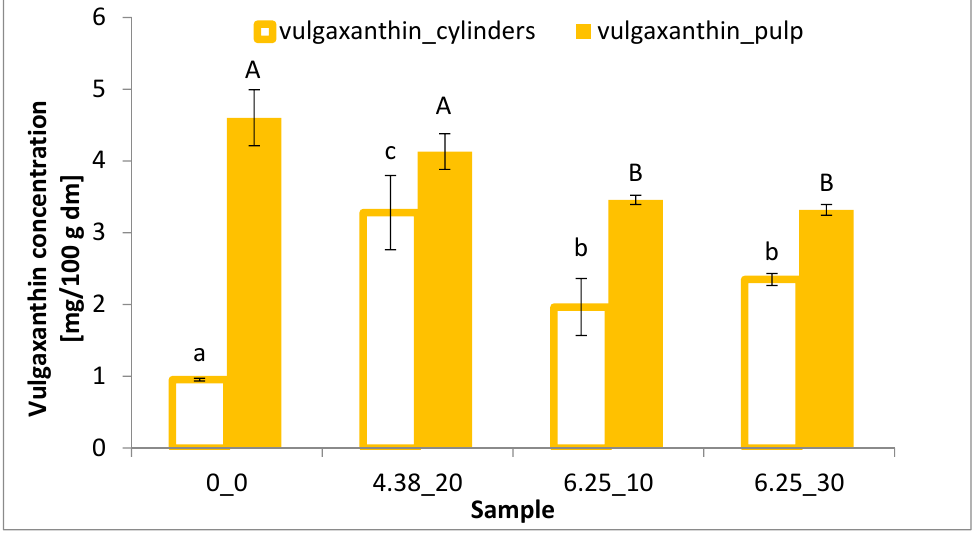
Figure 3. Vulgaxanthin concentration of differently treated beetroot cylinders and pulp. The same letter (and the same letter size) on the same column means no significant difference by the Tukey test ( p < 0.05).